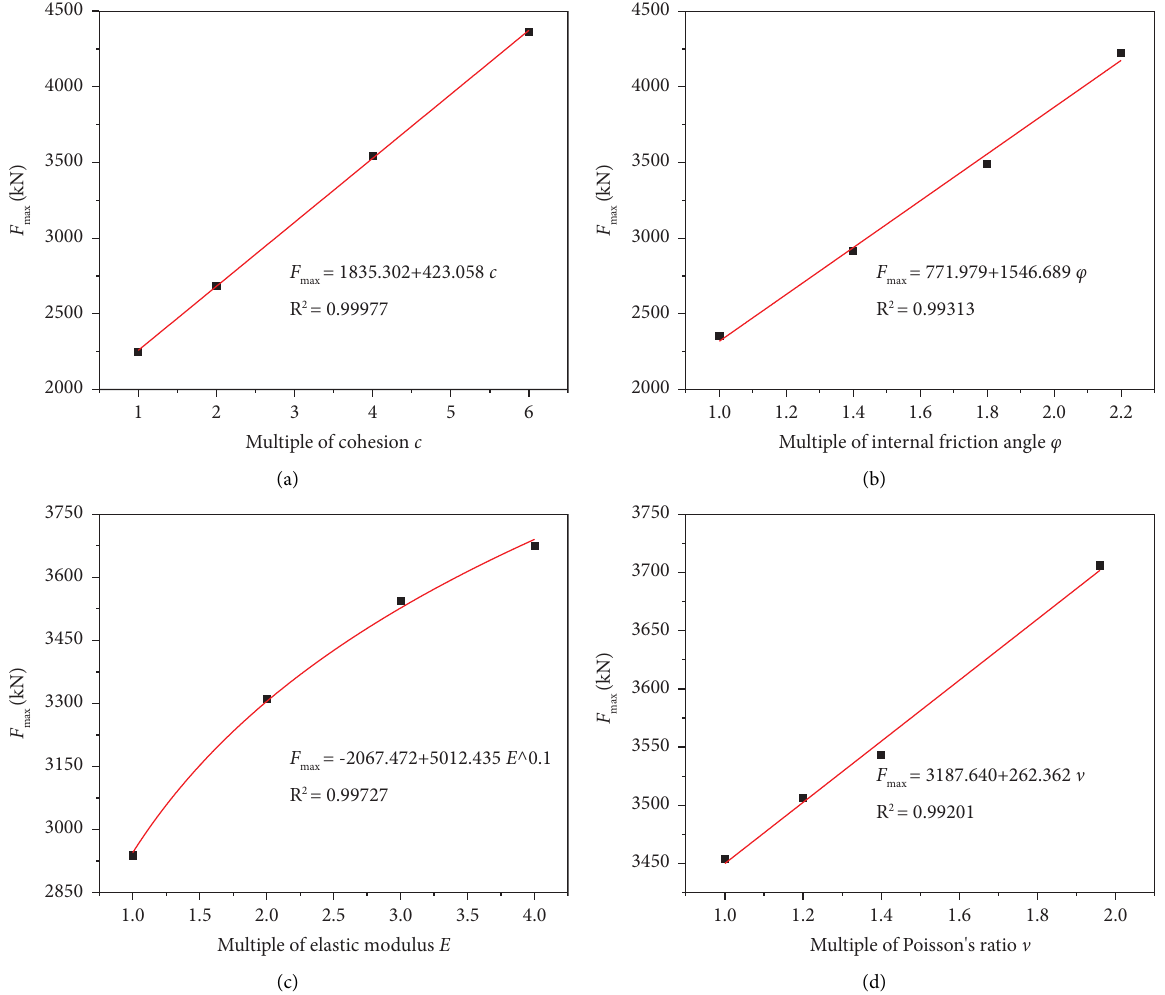
Figure 11: Infuence of soil conditions on maximum jacking force. (a) Cohesion. (b) Internal friction. (c) Elastic modulus. (d) Poisson’s ratio.